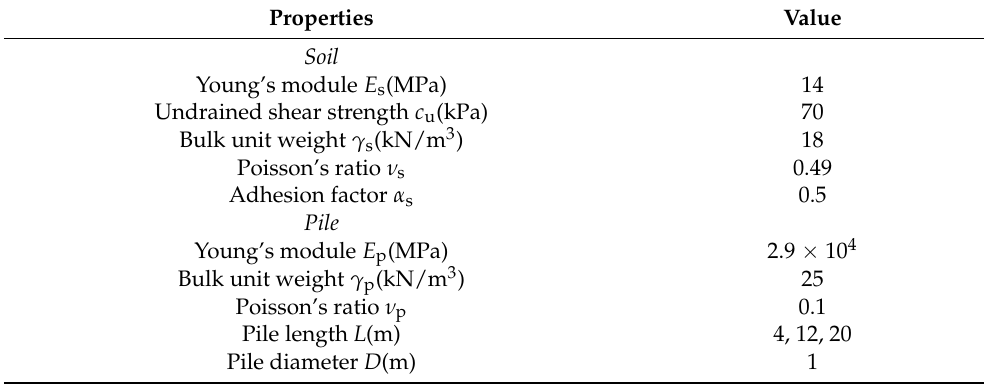
Table 3. Soil and pile properties.